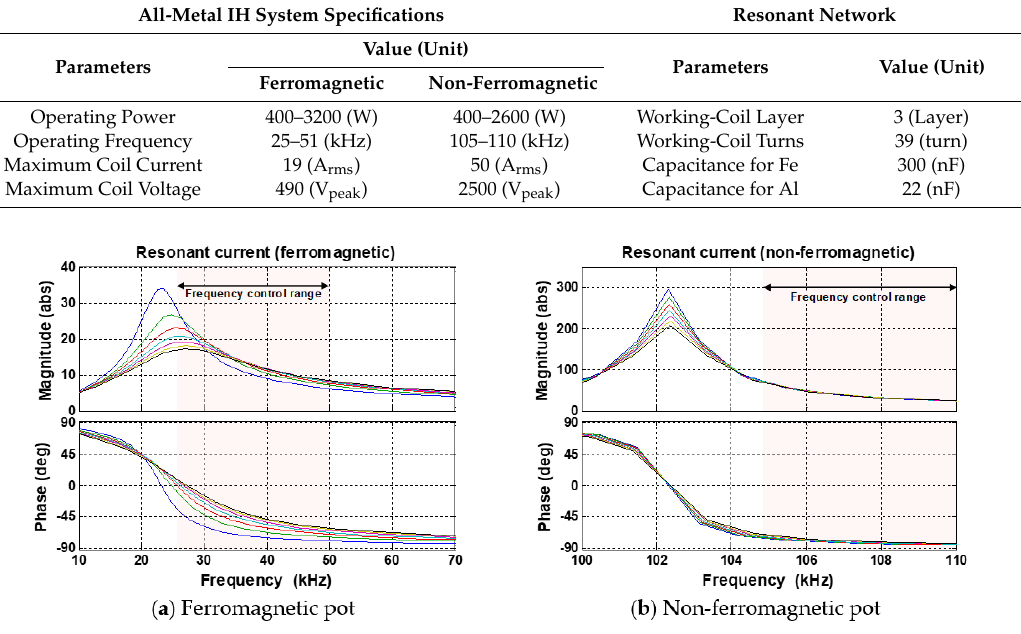
Figure 4. Current and phase of inverter according to frequency